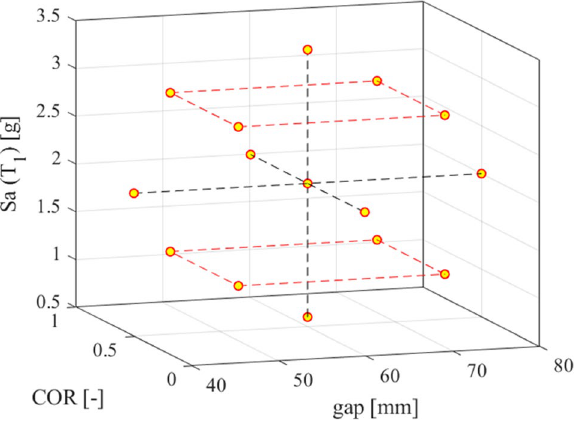
Figure 5. Central composite design (CCD) points for the three factors: gap, COR, and Sa(T 1 ).